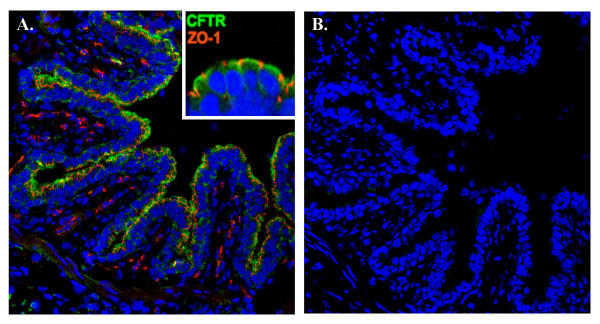
Immunocytochemical localization of CFTR in bronchiole epithelium. A.). Antibody R3194 against CFTR prominently labels (green) the apical margin of epithelial cells lining the bronchiole cut in cross section. Inset: high magnification view of epithelial cells showing demarcation of apical margin by tight junction-associated protein ZO-1 (red). B.) Control serial section stained without primary antibody.